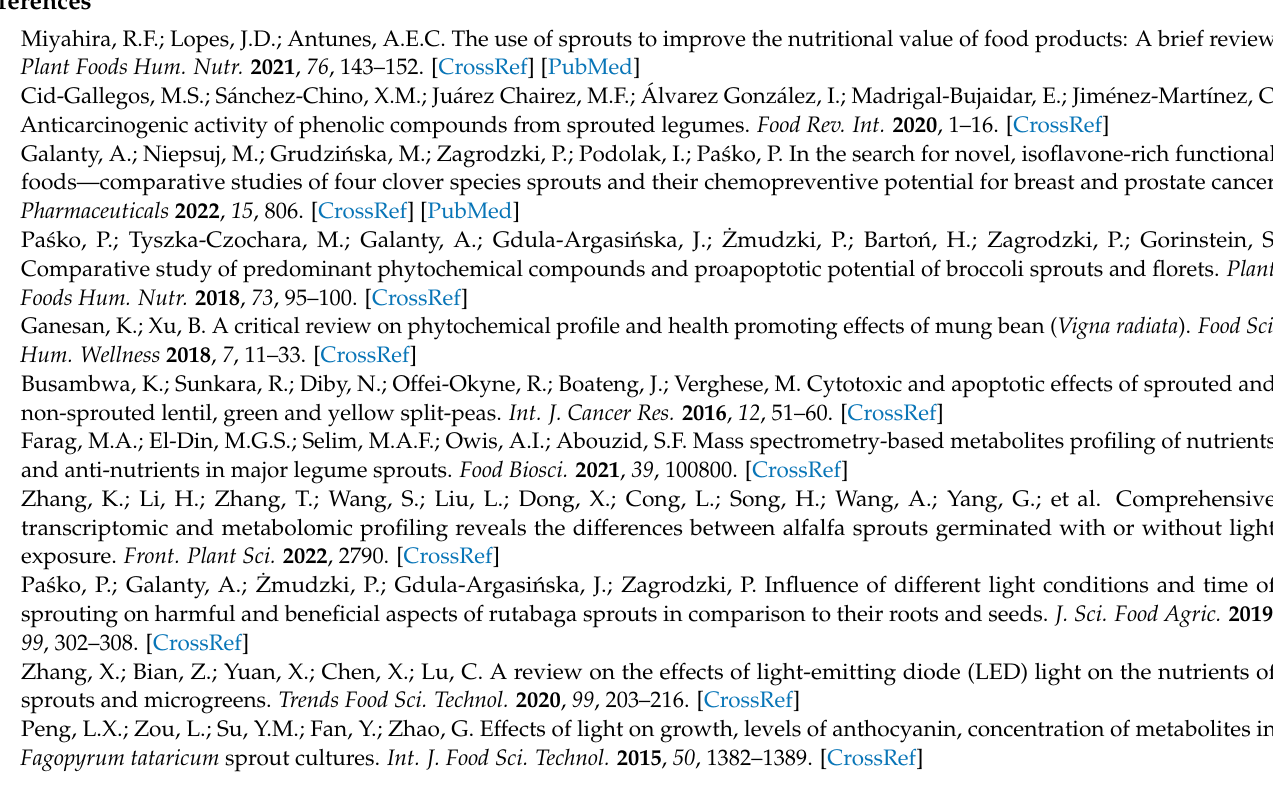
Supplementary Figure S2: Diagrams of evaluated isoflavones transformation in lupin sprouts in relation to the different light